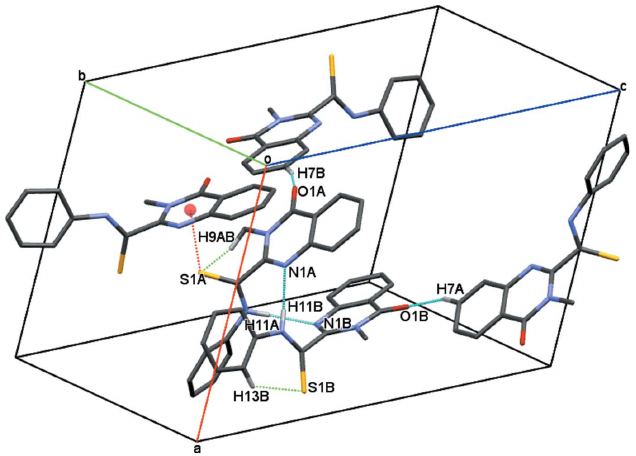
Figure 3 A diagram showing the intramolecular C—H (cid:3)(cid:3)(cid:3) S (green dashed lines) and the intermolecular N—H (cid:3)(cid:3)(cid:3) N (light blue dashed lines) and C— H (cid:3)(cid:3)(cid:3) O (blue dashed lines) hydrogen bonds, as well as C—S (cid:3)(cid:3)(cid:3) (cid:2) (red dashed lines) interactions present in the title compound. H atoms not involved in the interactions have been omitted for